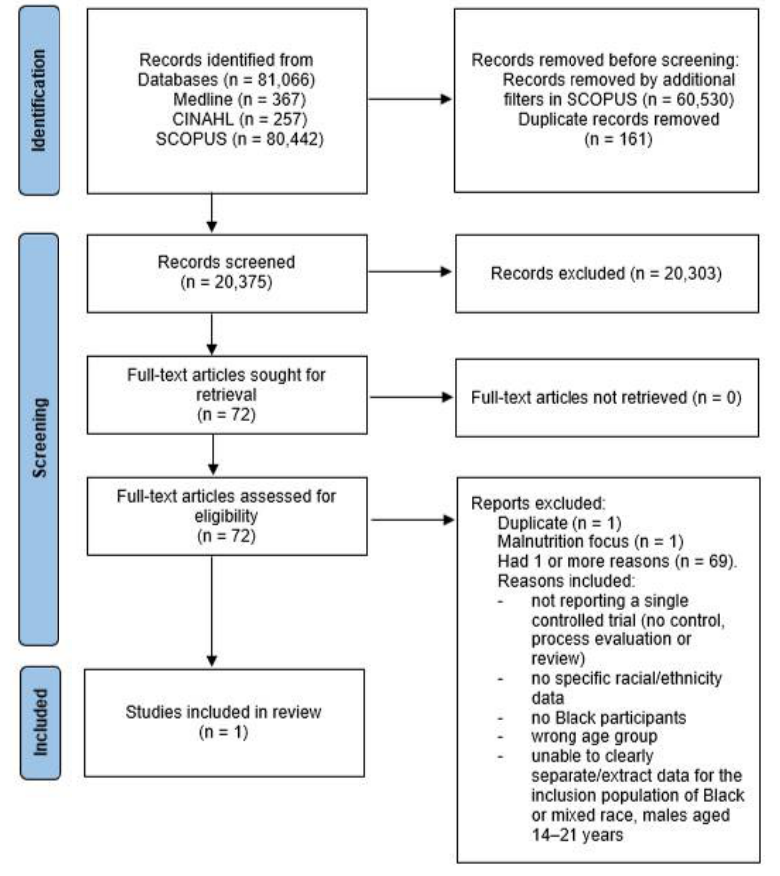
Figure 1. PRISMA Flow